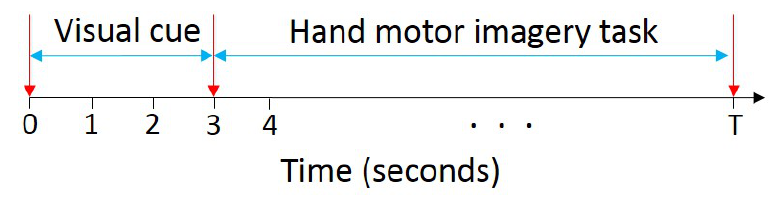
Figure 2. Experimental paradigm. A visual cue is displayed on the computer monitor for 3 s. After that, the visual cue disappears and a black screen is displayed on the monitor. During this period of time, the subject starts to imagine performing the movement that was specified by the visual cue until time T s. The value of T varies according to the complexity of the movement being imagined. In particular, for the movements in set 1 and set 3, T is equal to 10 s. For the extension-type grasp movement in set 2, T is equal to 12 s. Finally, for the small diameter grasp and lateral grasp movements in set 2, T is equal to 14 s.